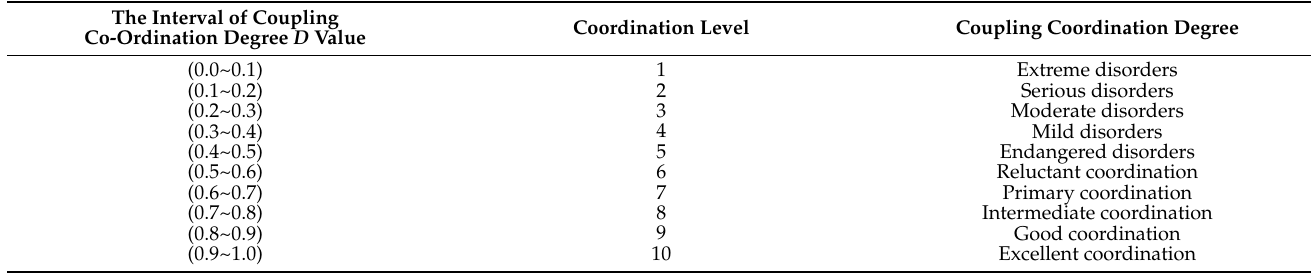
Table 3. Classification Criteria of Coupling Coordination